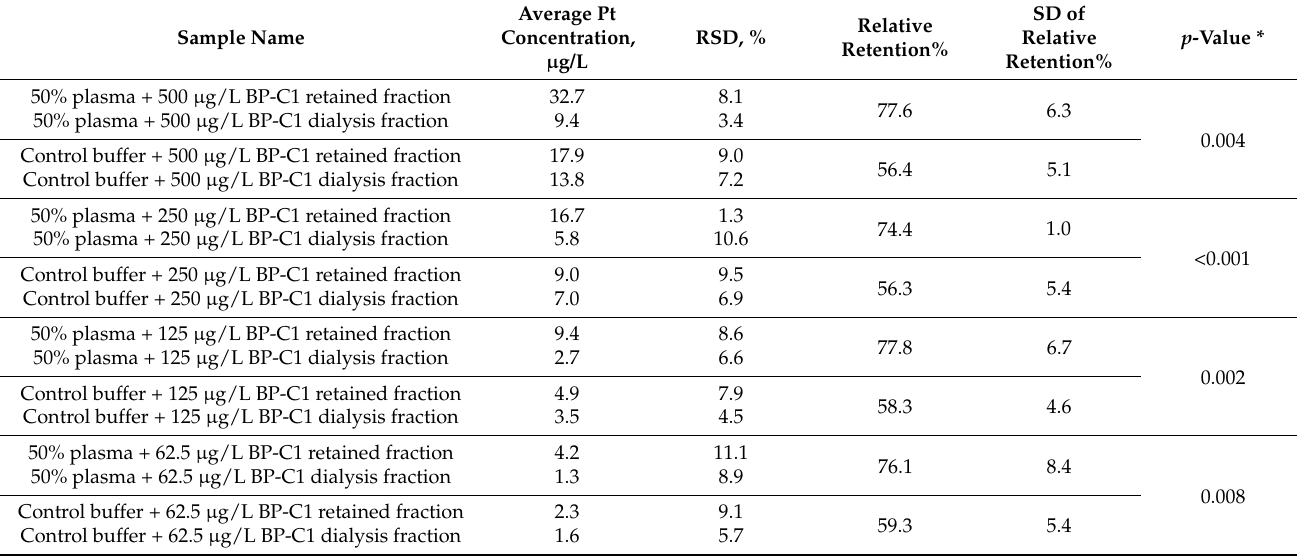
Table 1. Platinum (Pt) concentration and retention in the cells after dialysis equilibrium was established. Fifty percent plasma and control PBS dialysed against PBS with pH 7.2 for 4 h at 37 ◦ C across the 8 kDa cut-off vertical membrane. Pt was quantified by ICP-MS after microwave digestion. All dosage levels were tested in six parallel measurements ( n = 6). Fifty percent plasma samples were compared to the control buffer for the same dosage